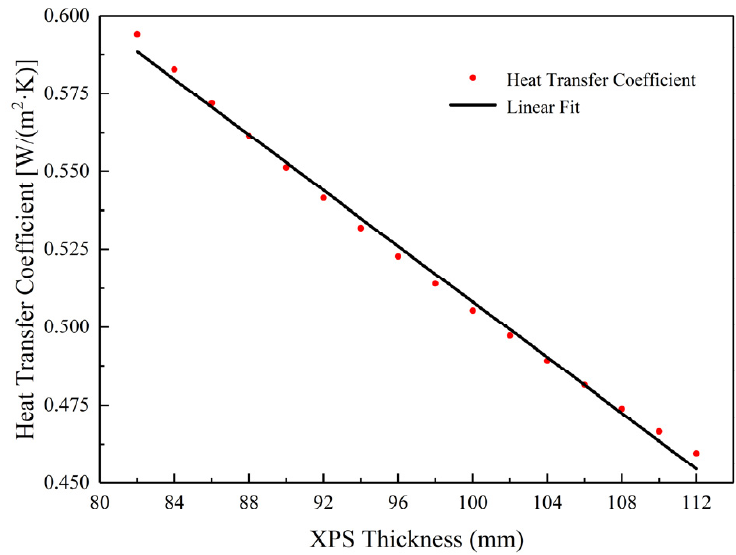
Figure 25. XPS thickness-heat transfer coefficient.